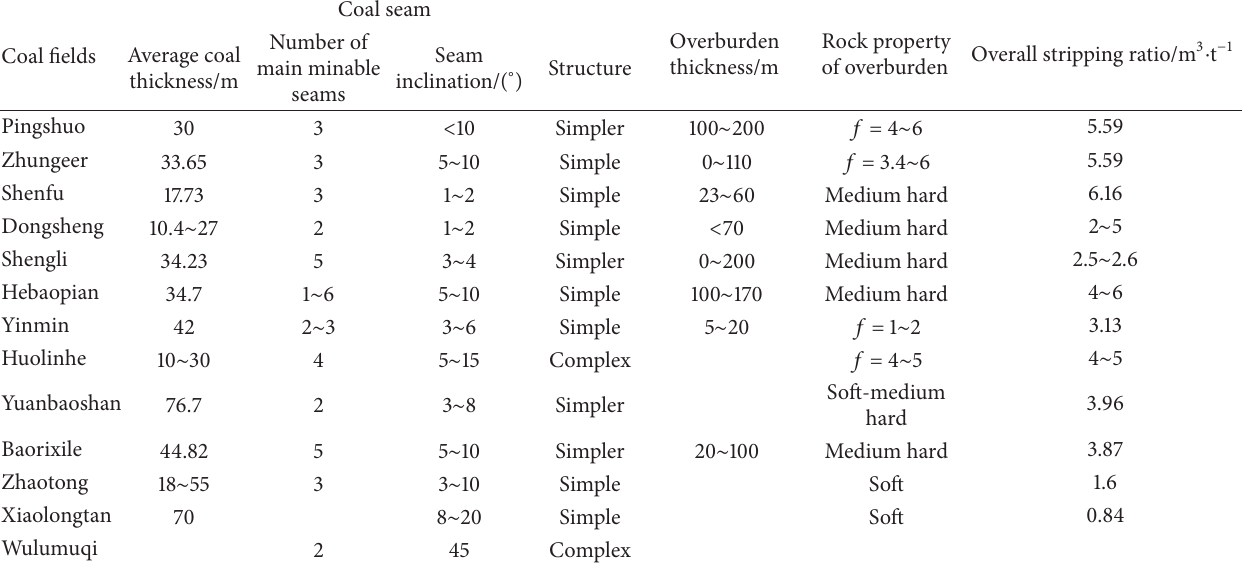
Table 1: Coal occurrence conditions of major opencast fields in